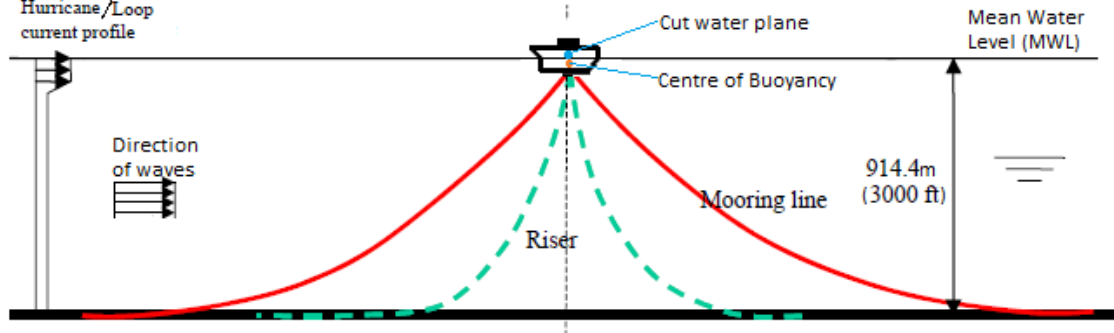
Figure 8. Schematic showing marine risers and mooring lines on a floating platform. The green lines are steel catenary risers (SCR), the black dash straight lines are top-tensioned risers (TTR) while the red lines are mooring lines.